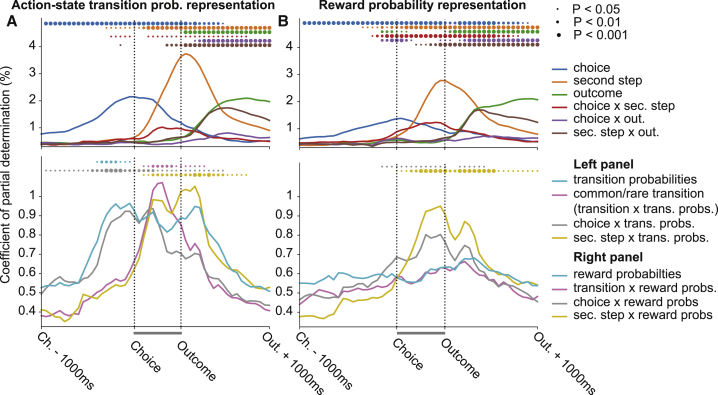
ACC Represents Model-Based Decision Variables(A) Regression analysis predicting neuronal activity as a function of events in the current trial (top panel) and their interaction with the transition probabilities (trans. probs.) mapping the first-step choice to second-step (sec. step) states (bottom panel) for a subset of sessions with sufficient coverage of both states of the transition probabilities. Predictors plotted in top panels are as in Figure 3E. Predictors plotted in the bottom panel are transition probabilities (which of the two possible states the transition probabilities are in; see Figure 1C), common/rare transition (whether the transition on the current trial was common or rare, i.e., the interaction of the transition on the current trial [e.g., top → right] with the state of the transition probabilities), choice × trans. probs. (the choice in the current trial interacted with the state of the transition probabilities, i.e., the predicted second-step state given the current choice), and sec. step × trans. probs. (the second-step state reached on the current trial interacted with the state of the transition probabilities, i.e., the action which commonly leads to the second-step state reached). Predictors shown in top and bottom panels of (A) were run as a single regression but plotted on separate axes for clarity. The gray bars between choice and outcome indicate the time period that was warped to align trials of different length. Circles indicate where CPD is significantly higher than expected by chance, assessed by permutation test with Benjamini-Hochberg correction for comparison at multiple time points.(B) Regression analysis predicting neuronal activity as a function of events on the current trial (top panel) and their interaction with the reward probabilities in the second-step states (bottom panel) for a subset of sessions with sufficient coverage of different states of the reward probabilities. Predictors plotted in the bottom panel are reward probabilities (which of the three possible states the transition probabilities are in; see Figure 1C), transition × reward probs. (interaction of the transition in the current trial with the state of the reward probabilities), choice × reward probs. (the choice in the current trial interacted with the state of the reward probabilities), and sec. step × trans. probs. (the second-step state reached in the current trial interacted with the state of the rewarded probabilities, i.e., the expected outcome [rewarded or not]. Predictors shown in top and bottom panels of (B) were run as a single regression but plotted on separate axes for clarity.